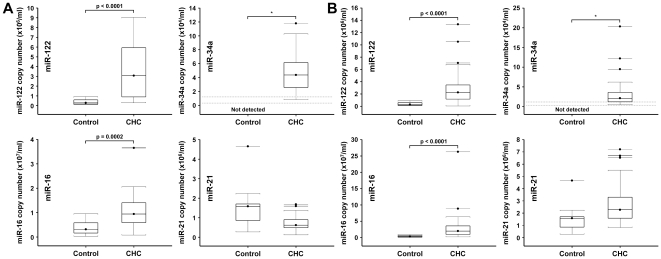
Up-regulation of serum miR-122, miR-34a and miR-16 in chronic hepatitis C patients.Serum levels of miR-122, miR-34a, miR-16 and miR-21 in (A) a first set of 18 CHC patients and (B) an independent set of 35 CHC patients. CT values were converted to an absolute value based on the standard curves. Serum miRNA expression levels are expressed in copy number/ml. In the box-plot displays, the bold line indicates the median per group, the box represents 50% of the values and horizontal lines show minimum and maximum values of the calculated non-outlier values. For miR-34a, the dashed lines represent the levels corresponding to CT values between 35 and 37 (1.2×104 – 0.3×104copies/ml).